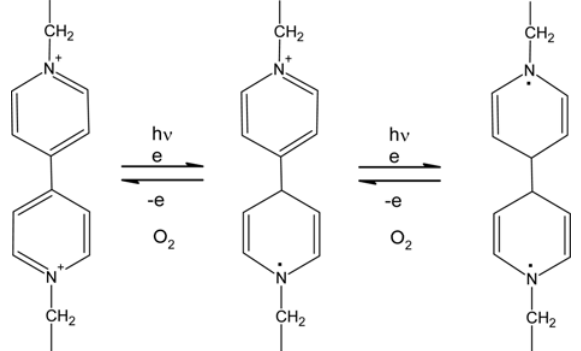
Figure 12. Reversible reduction and oxidation of a viologen moiety of the anion exchange